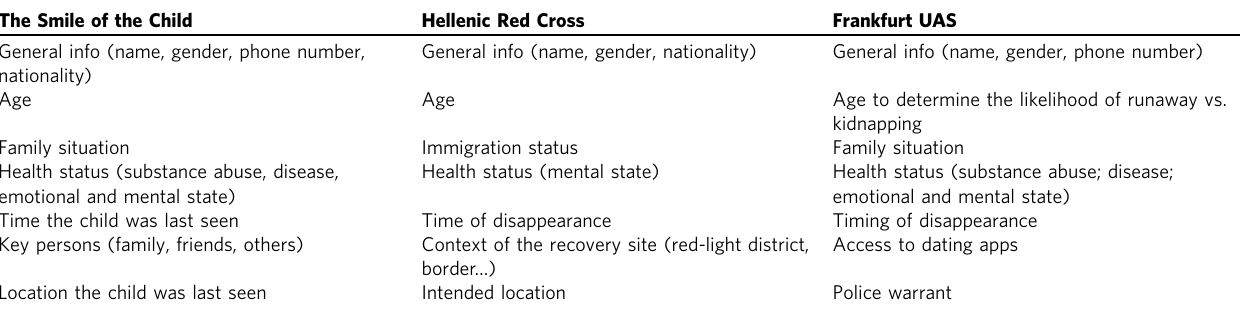
Table 1 Key information as identi fi ed in the interviews conducted by the partners. The Smile of the